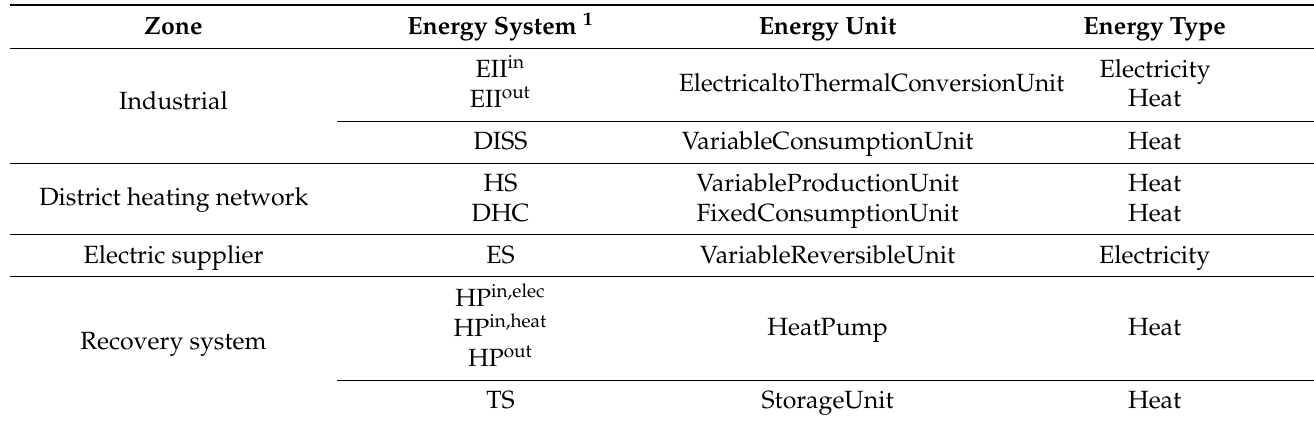
Table 2. Correspondence between energy systems and energy units.